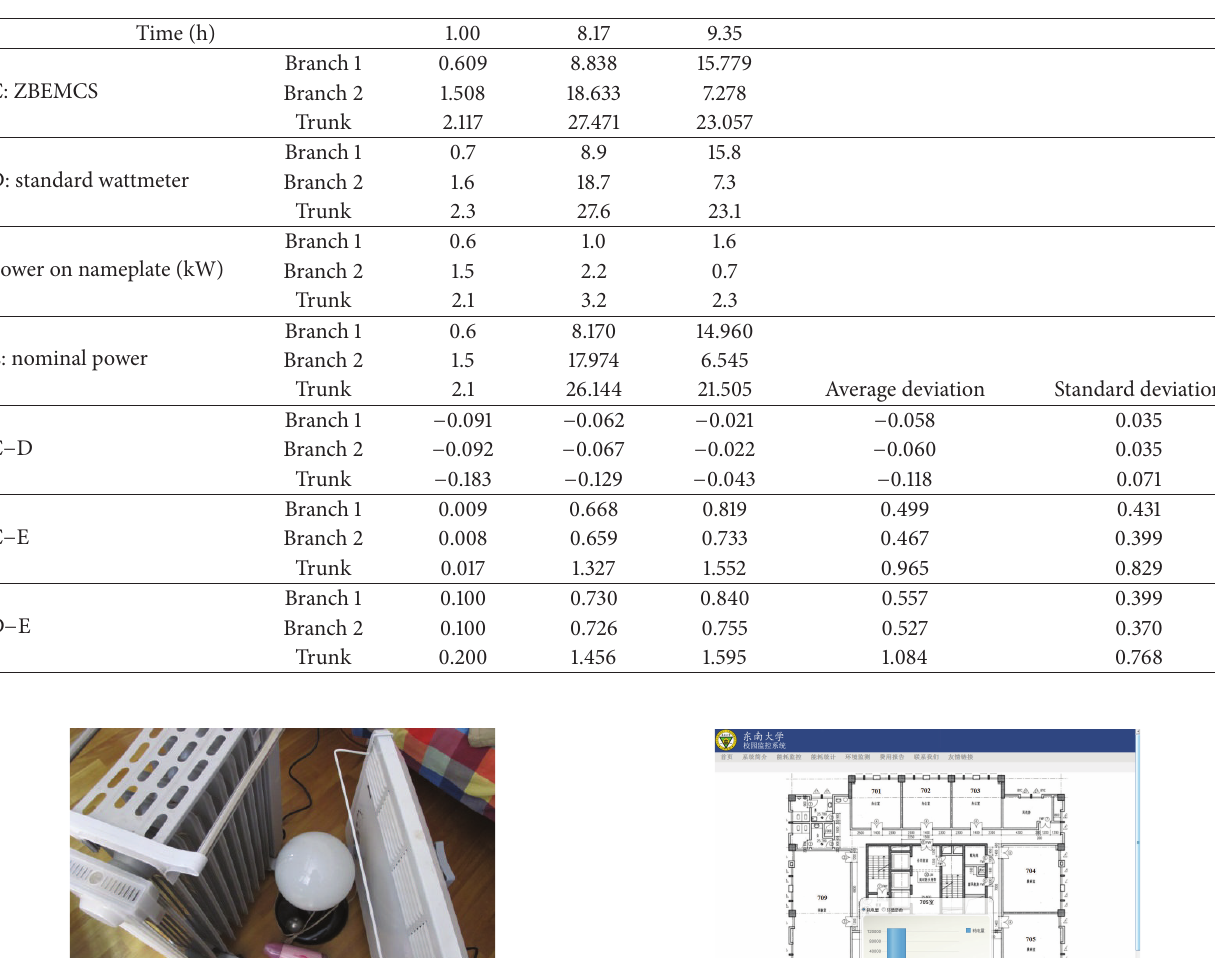
Table 3: Power consumption data for two electric heaters (kWh).